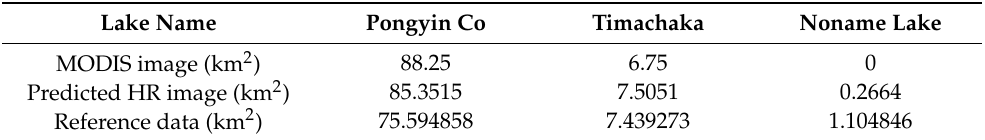
Figure 9. SR Results of real-world situations. MODIS image with an original spatial resolution of 500 m is improved to 30 m resolution. ( a ) MODIS data, ( b ) Predicted HR data, ( c ) Landsat 8 data. Table 5. Area estimation results of selected